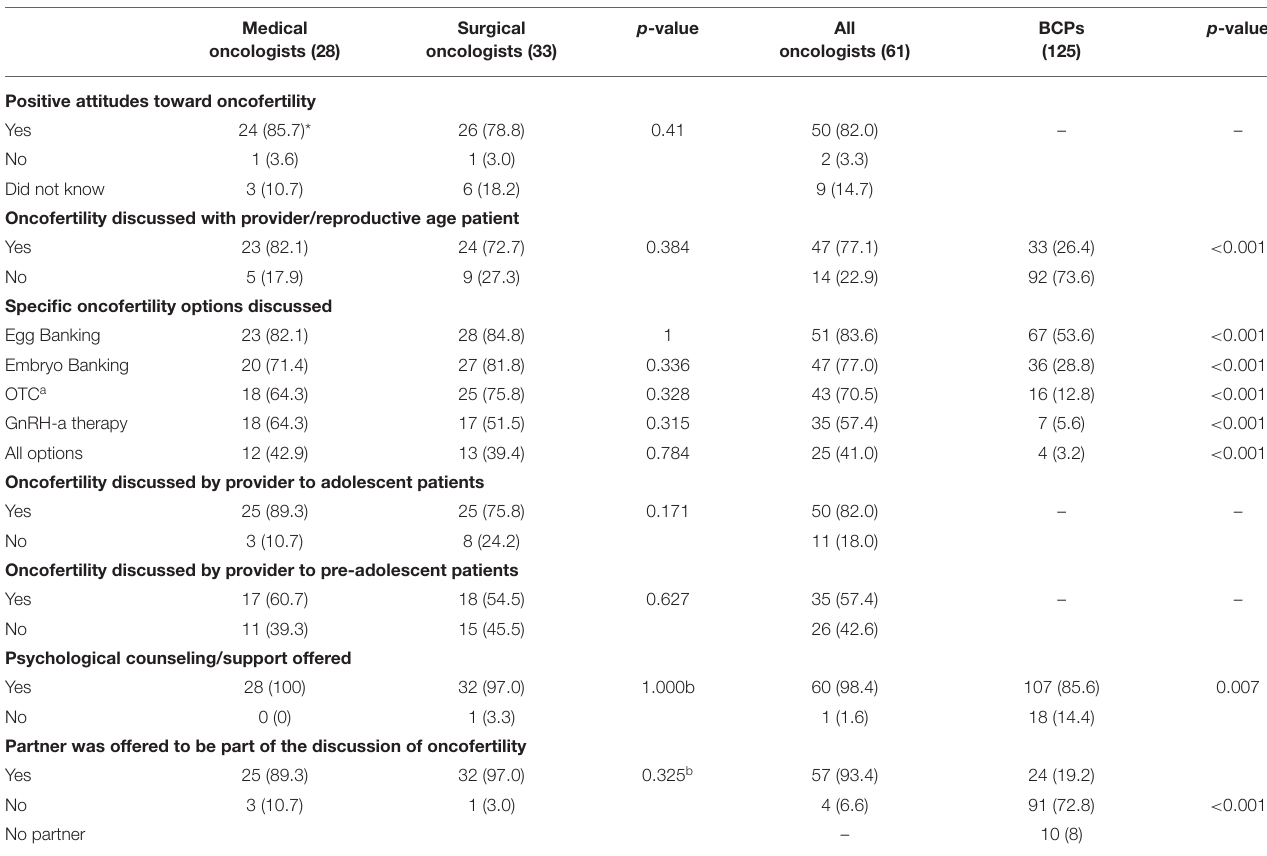
TABLE 4 | Treatment-services discussed and attitudes related to oncofertility